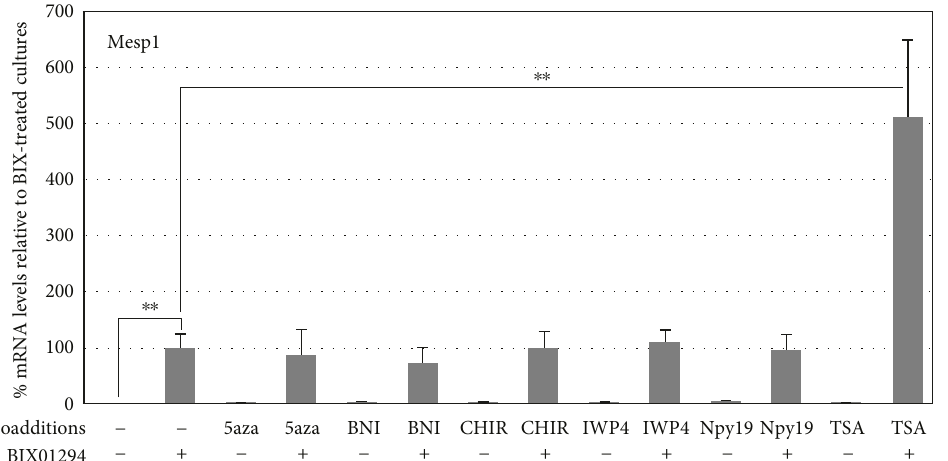
Figure 1: TSA synergistically enhances stimulation of Mesp1 expression by BIX01294. MSCs were incubated with various compounds plus or minus BIX01294 over a broad range of concentrations, with RNA harvested 2 days later and analyzed for Mesp1 expression by qPCR. The chart presents summarized results using optimized doses of inhibitors speci fi c for G9a HMTase (BIX01294), DNA methylation (5- azacytidine (5aza)), nitric oxide synthase (3-bromo-7-nitroindazole (BNI)), GSK3 β (CHIR99021 (CHIR)), Wnt (IWP4), TGF β (1,5- naphthyridine pyrazole derivative-19 (Npy19)), and histone deacetylase (trichostatin A (TSA)). The numbers of biological repeats represented in the graphed data are as follows: control and BIX01294 ( n = 31 ) and BIX01294+TSA ( n = 18 ), with remaining groups having n values ranging from 3 to 5. BIX01294 was the only reagent by itself that was able to induce Mesp1 expression, with > 83-fold increase over control levels ( ∗∗ p < 0 005 ). None of the other drugs were able to increase Mesp1 expression. However, of these latter drugs, only TSA when combined with BIX01294 produced a signi fi cant enhancement of Mesp1-expression over the levels obtained from the BIX01294 only treated cultures ( ∗∗ p < 0 005 ). Note that the relative levels of Mesp1 gene expression are normalized to levels obtained from BIX01294-treated MSC